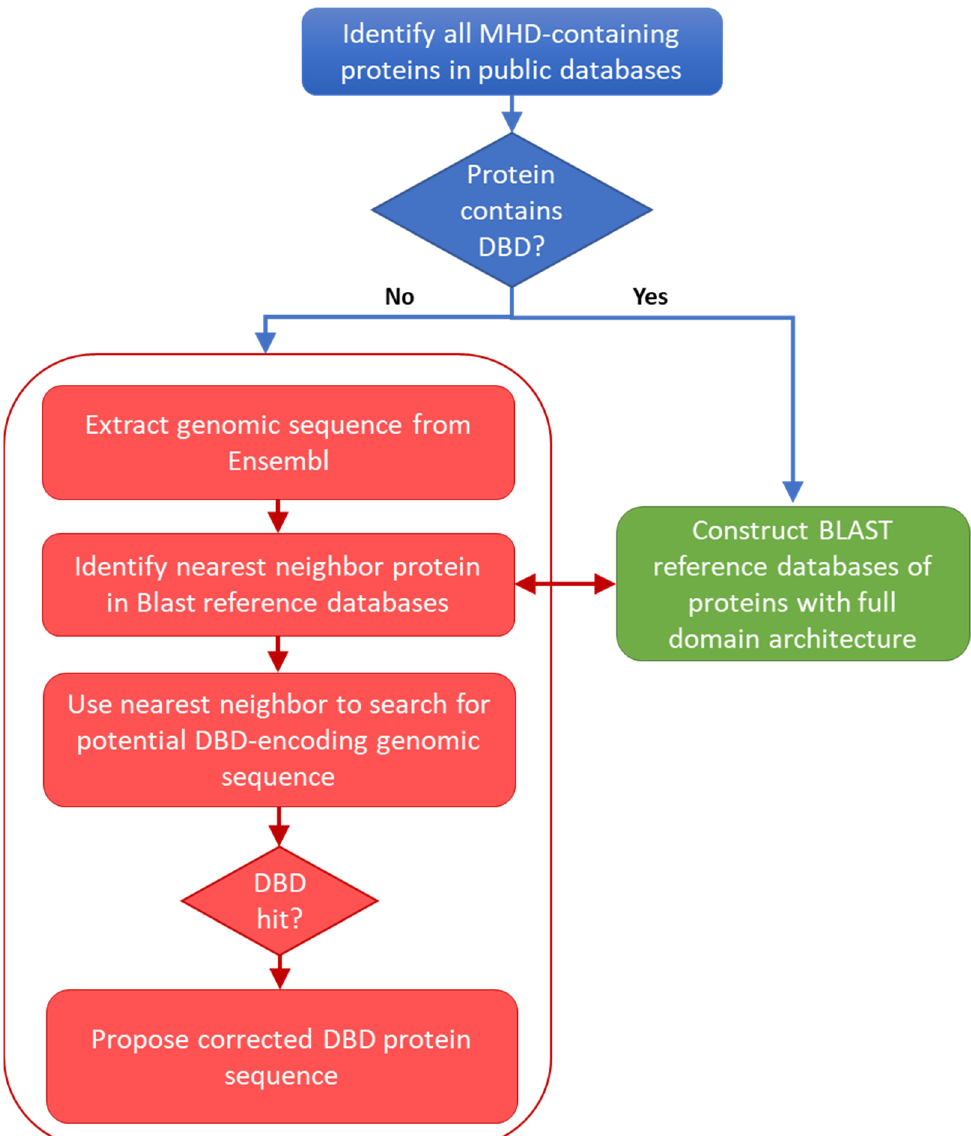
Figure 1. Schema of the protocol used to locate potential errors in sequences retrieved from public databases.